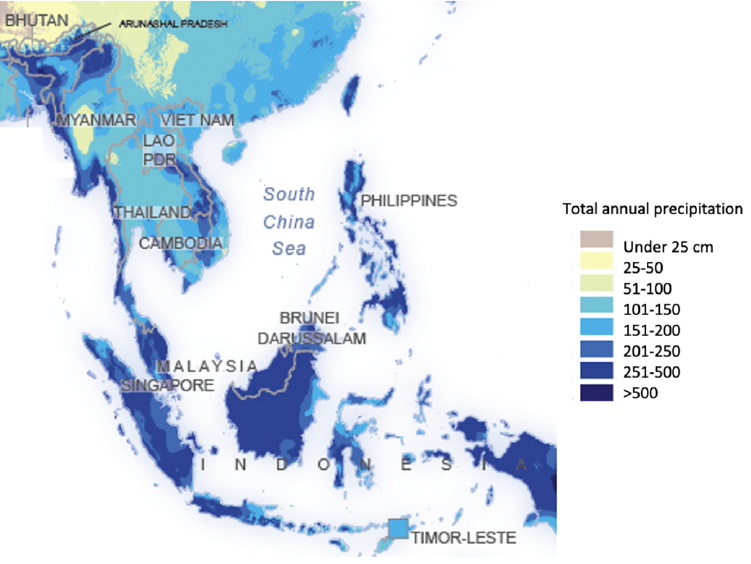
Figure 3. Map of annual precipitation in Southeast Asia [14] .